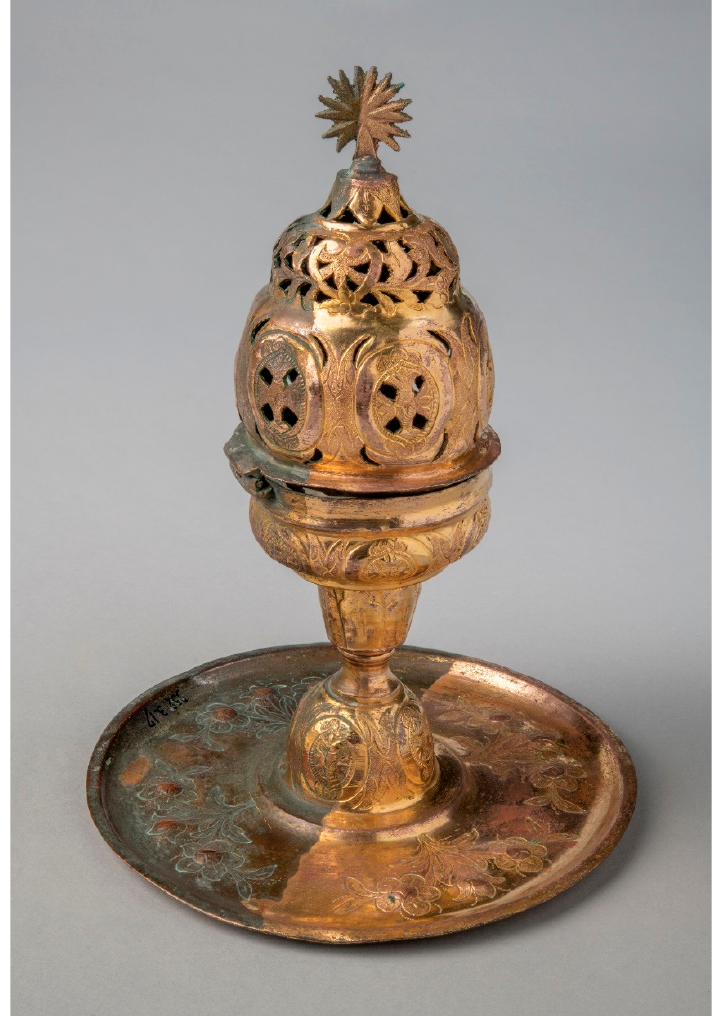
Figure 2. The Armenian censer from the Dobrée Museum collection during treatment (© L. Preud’homme/Arc’Antique—Grand Patrimoine de Loire Atlantique, Nantes, France).